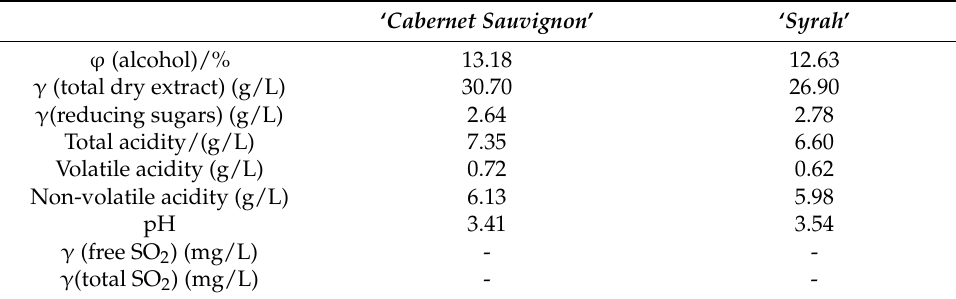
Table 2. Standard physicochemical parameters of base